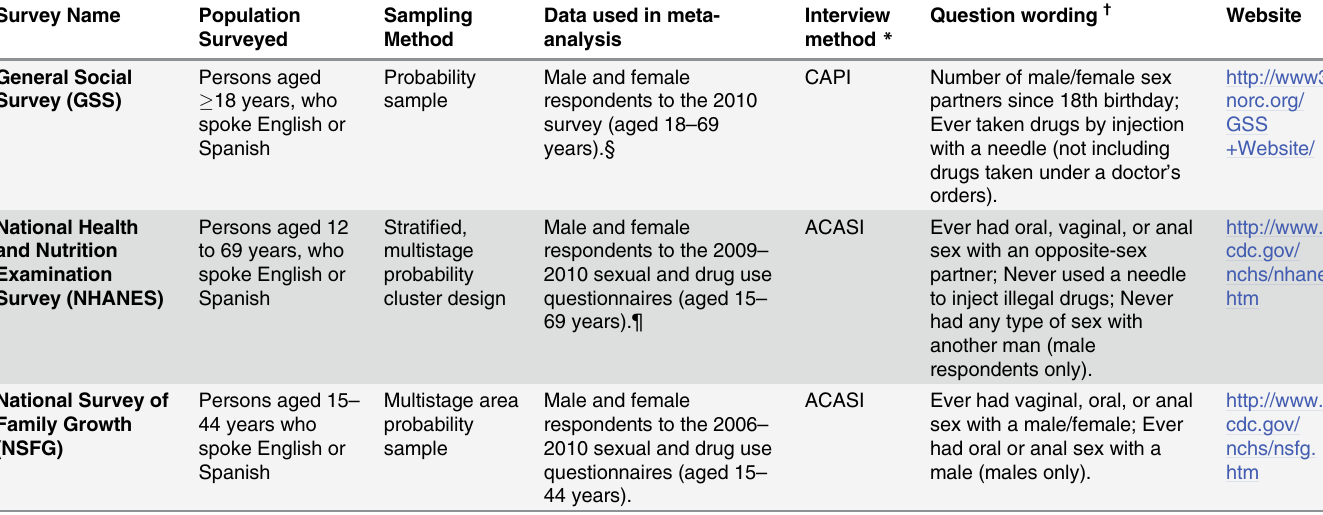
Table 1. Description of 3 national household surveys of the non-institutionalized population of the United States used in meta-analysis. CAPI = Computer-Assisted Personal Interview; ACASI = Audio, Computer-Assisted Self